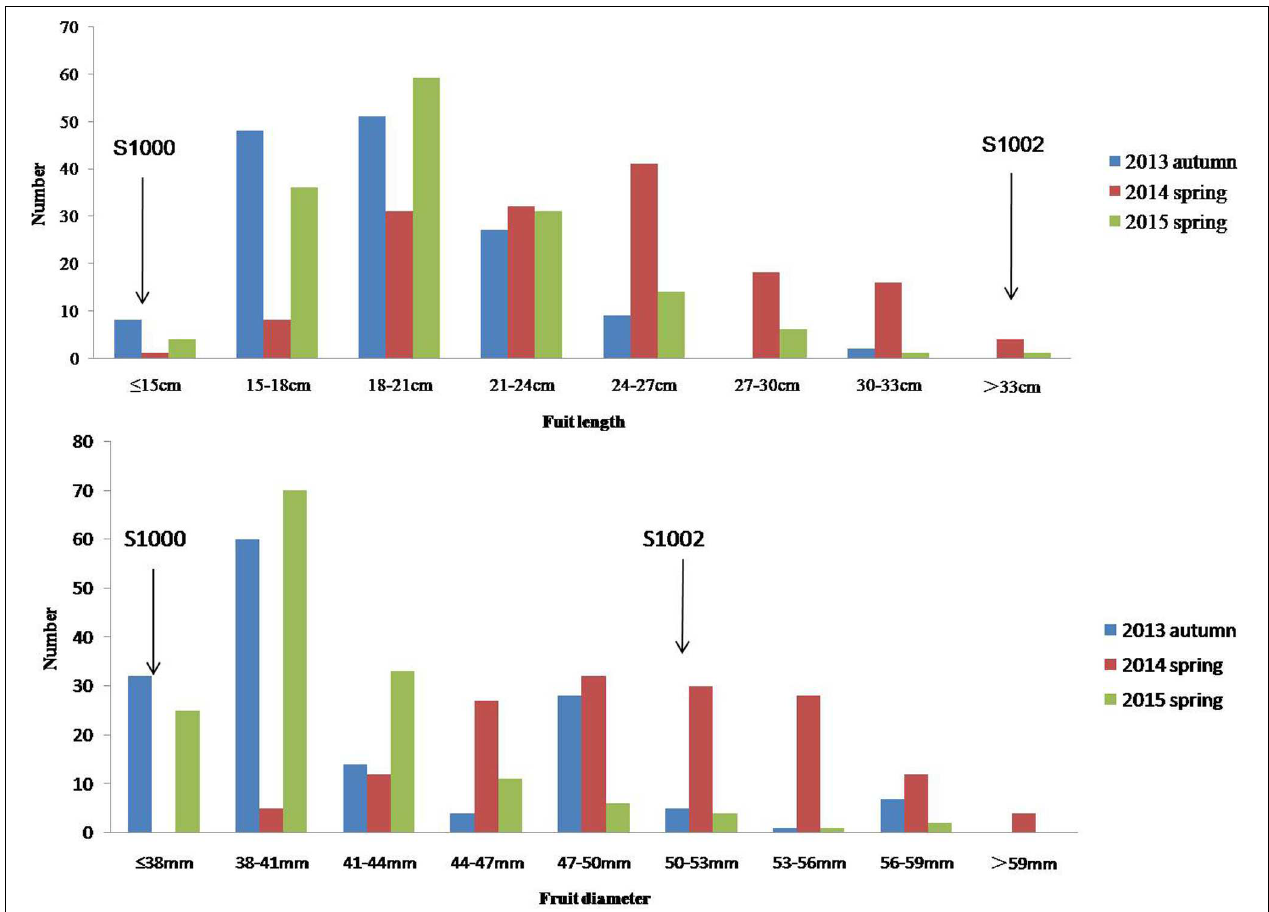
FIGURE 3 | Phenotypic evaluation of fruit length and fruit diameter for S1000, S1002, and F 3 . The Y axis is the number of plant individuals. The X axis is continuous, for the figure fruit length, it means the fruit length (fl) ≤ 15 cm, 15 cm < fl ≤ 18 cm, 18 cm < fl ≤ 21 cm, 21 cm < fl ≤ 24 cm, 24 cm < fl ≤ 27 cm, 27 cm < fl ≤ 30 cm, 30 cm < fl ≤ 33 cm, fl > 33 cm; for the fruit diameter, it means the fruit diameter (fd) ≤ 38 mm, 38 mm < fd ≤ 41 mm, 41 mm < fd ≤ 44 mm, 44 mm < fd ≤ 47 mm, 47 mm < fd ≤ 50 mm, 50 mm < fd ≤ 53 mm, 53 mm < fd ≤ 56 mm, 56 mm < fd ≤ 59 mm, fd > 59.